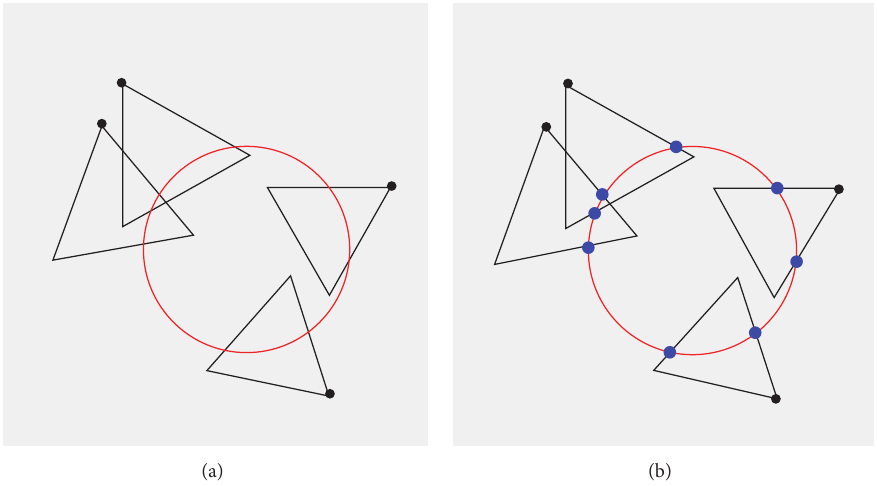
Figure 5: Visual representation of intersection points. (a) Original target; (b) intersection